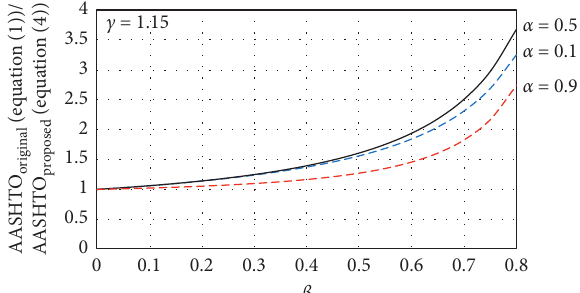
Figure 11: Comparison of errors between original and proposed AASHTO equations.